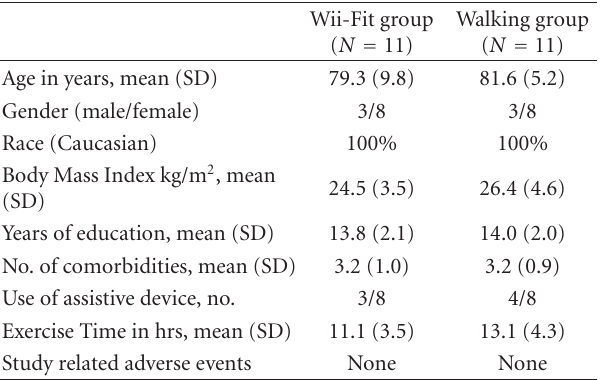
Table 1: Study subject characteristics for the Wii-Fit and walking groups ∗ .